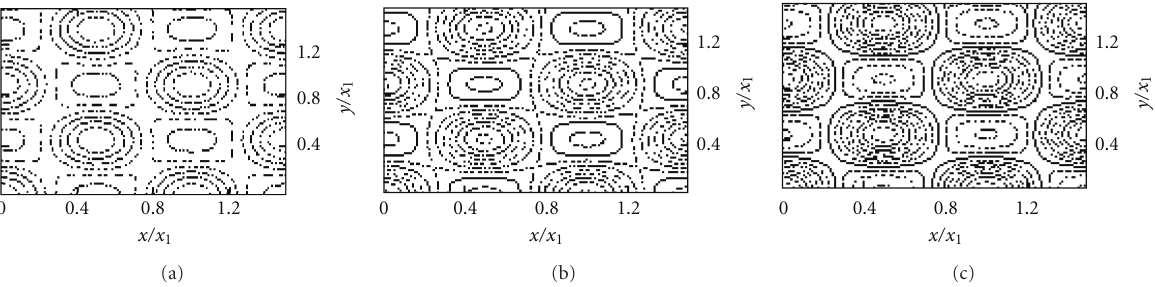
Figure 3: Variation of magnetic field distribution B ( x , y ) for di ff erent temperatures ( t = 0 . 9,0 . 7,0 . 5) ((a)–(c)) respectively, calculated by the extended two-order parameter GL theory. Other parameters used for the calculation are same as in Figure 2. The reversible magnetization of the system calculated by this expression at di ff erent temperatures is plotted in Figure 4.